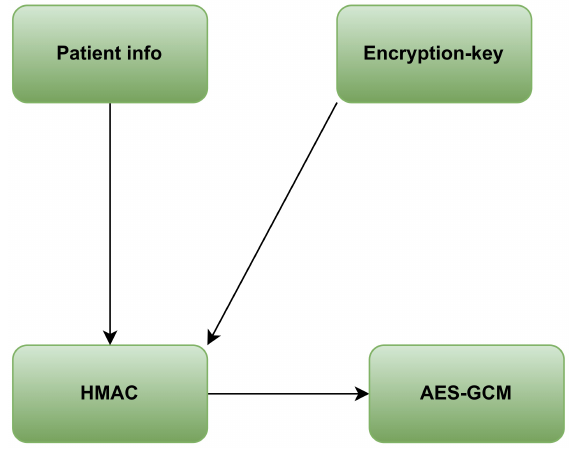
Figure 3. Key Agreement Module.